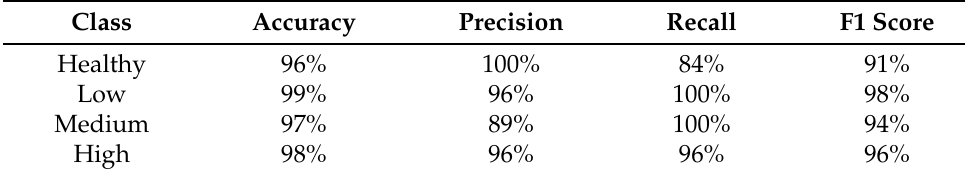
Table 4. Accuracy, precision, recall and F1 score of the